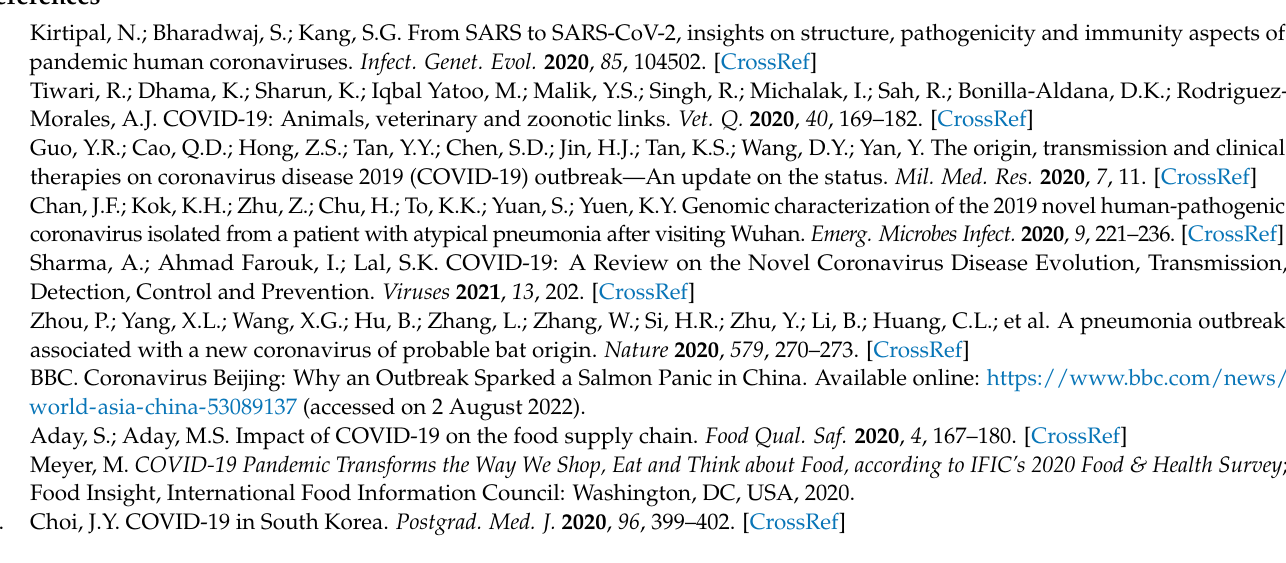
market; Figure S5: Locations and frequency of ASF selling by retailers; Figure S6: Labor resource and time spent on ASF selling; Figure S7: Impacts of COVID-19 to ASF purchasing and selection of the consumers; Figure S8: Preference type of retail and purchasing frequency of consumers; Figure S9: Average amount of ASF purchased (kg) per shopping trip of consumers; Figure S10: Difficulties of consumers in ASF purchasing; Figure S11: Impacts of COVID-19 on consumer livelihood; Figure S12: Knowledge of ASF retailers; Figure S13: Attitudes of retailers; Figure S14: Practices toward food safety of retailers; Figure S15: Knowledge of ASF consumers; Figure S16: Attitudes of consumers; Figure S17: Practices toward food safety of consumers; Table S1: Differences of KAP scores between retailers in U/PU and rural areas; Table S2: Differences of KAP scores between consumers in U/PU and rural areas; Table S3: Multivariable analysis results of retailers; Table S4: Multivariable analysis results of